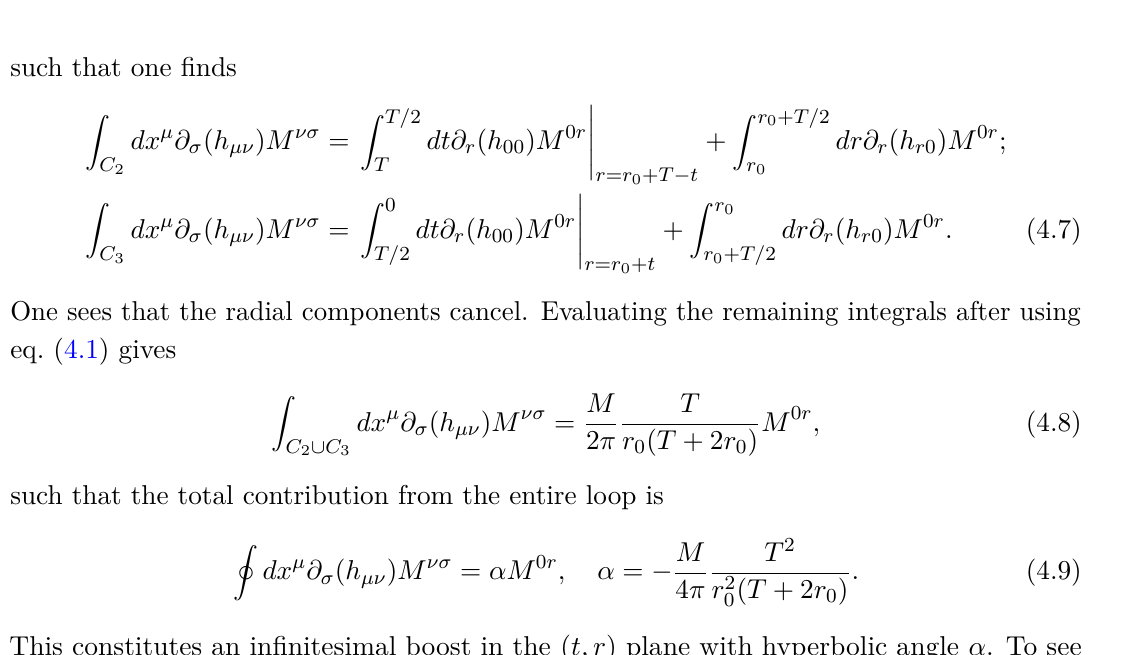
Figure 1 . A loop consisting of three segments in the ( r, t ) plane, where C 2 and C 3 are null